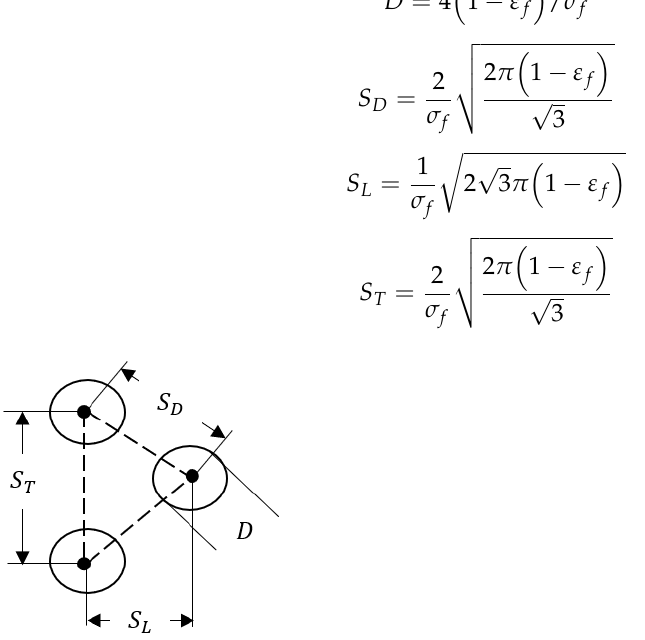
Figure 3. The equilateral-triangle arrangement. The longitudinal, transverse, and diagonal pitches, as well as the diameter, are measured in mm. as well as the diameter, are measured in